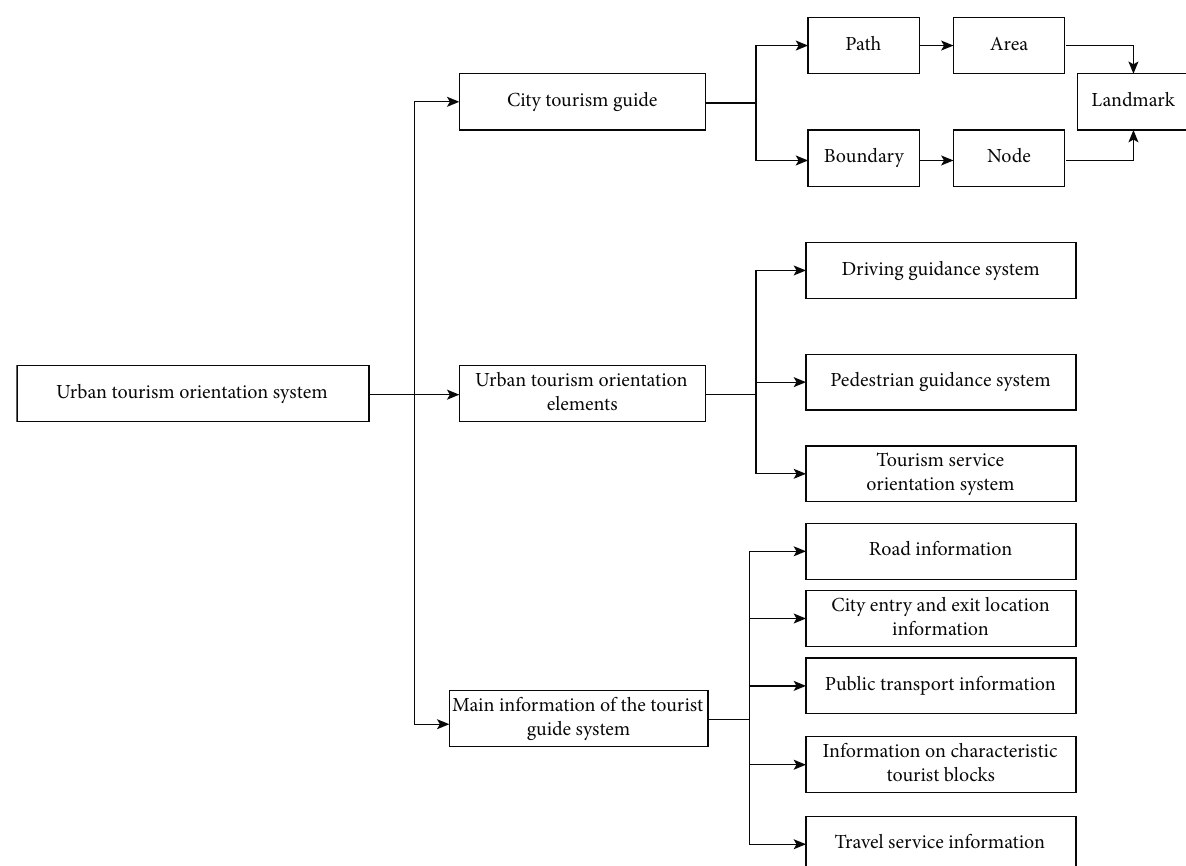
Figure 3: Component diagram of urban tourism guidance